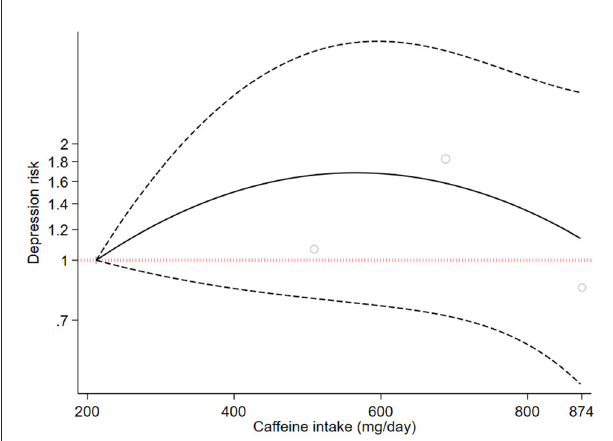
FIGURE6 Dose-response association between caffeine intake and depressive symptoms. The solid line represents a non-linear dose response, and the dotted lines represent a 95% confidence interval. Circles represent hazard ratio point estimates for coffee intake categories from each study with circle size proportional to the inverse of standard